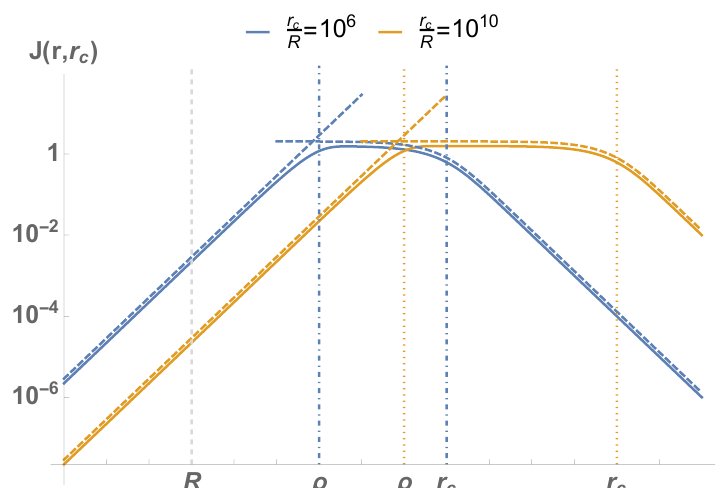
Figure 5. This log-log plot shows the numerical value of J , as a function of r (in units of R ), for two di(cid:11)erent values of r c =R as solid curves. The blue curve is plotted for r c =R = 10 6 and the orange one for r c =R = 10 10 . The dashed curves are the functions J DGP , for r & (cid:26) , and (cid:25) p r . (cid:26) , in two di(cid:11)erent colors depending on the value of r c =R . We see that J is approximated